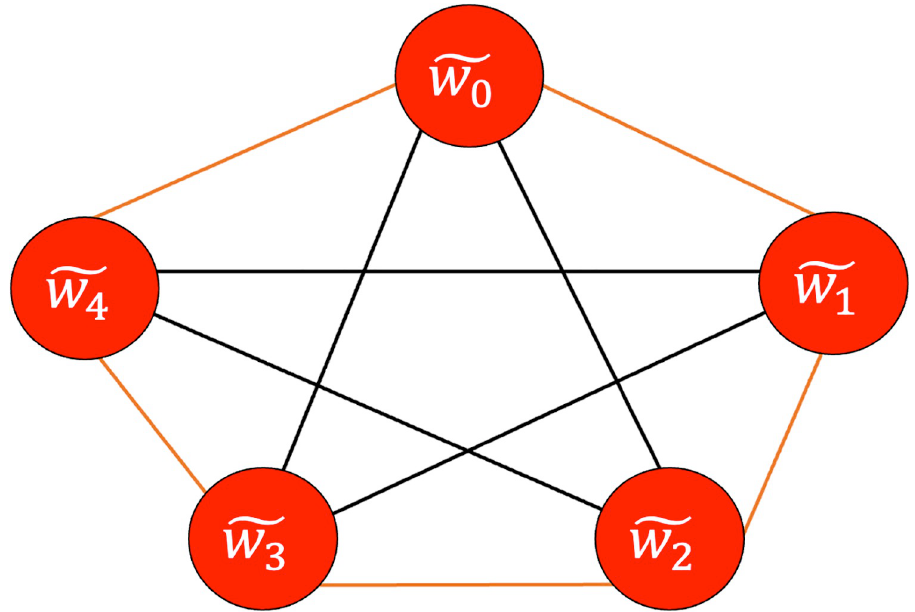
Fig 2. An example of a non-planar